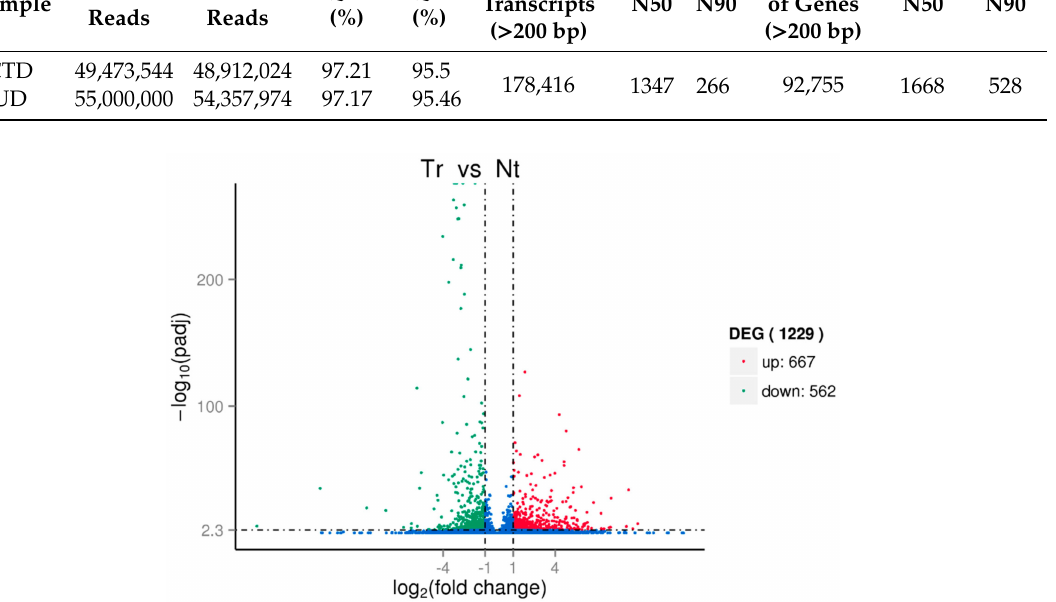
Figure 4. Di ff erential expression genes (DEGs) identified in Populus simonii × P. nigra under cold treatment and untreated